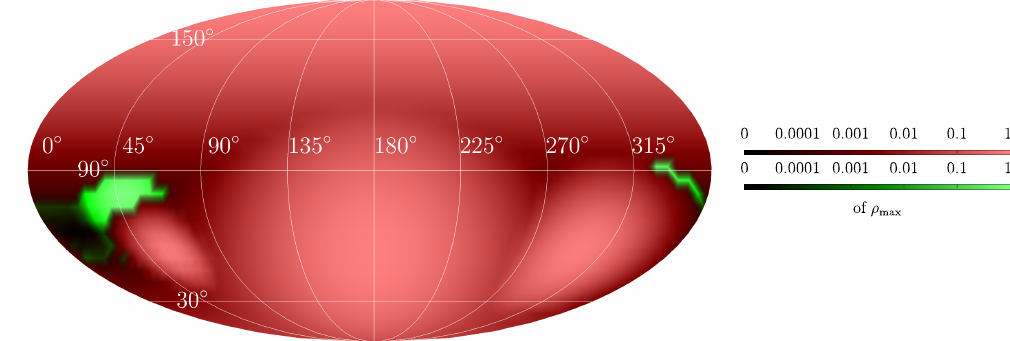
Figure 2. Mollweide projection of the differential signal photon number ρ gives the coordinate ϕ and the latitude ϑ . The three different colors denote the considered frequency regimes, i.e., k i ,1 = 0.97eV to k f ,1 = 2.13eV (red), k i ,2 = 2.52eV to k f ,3 = 3.68eV (green) and k i ,3 = 5.62eV to k f ,3 = 6.78eV (blue). The color scale is linear and normalized to the maximum values ρ max of each frequency regime. Next to the main peaks coinciding with the propagation directions of the driving beams, there are additional, less pronounced peaks in other directions.